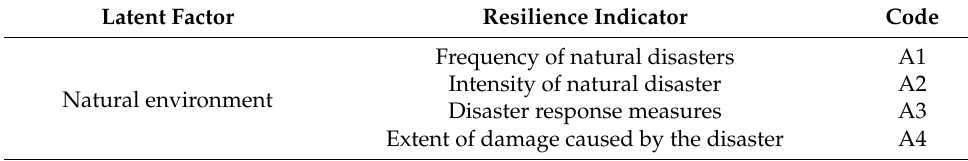
Table 1. The four latent factors and their resilience indicators of the underground public space (UPS) system. Latent Factor Resilience Indicator Code Frequency of natural disasters A1 Intensity of natural disaster A2 Natural environment Disaster response measures A3 Extent of damage caused by the disaster A4 Quantity of emergency relief materials B1 Financial allocation for post-disaster relief B2 Material reserves for post-disaster reconstruction Economic environment Number of professional rescue